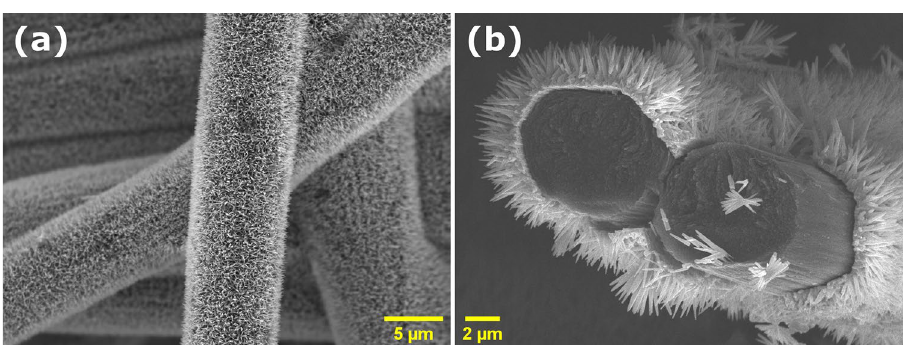
Figure 2. SEM images of C-fibers coated with Al-doped ZnO NPs/NRs from ( a ) a top view and ( b ) a cross- sectional